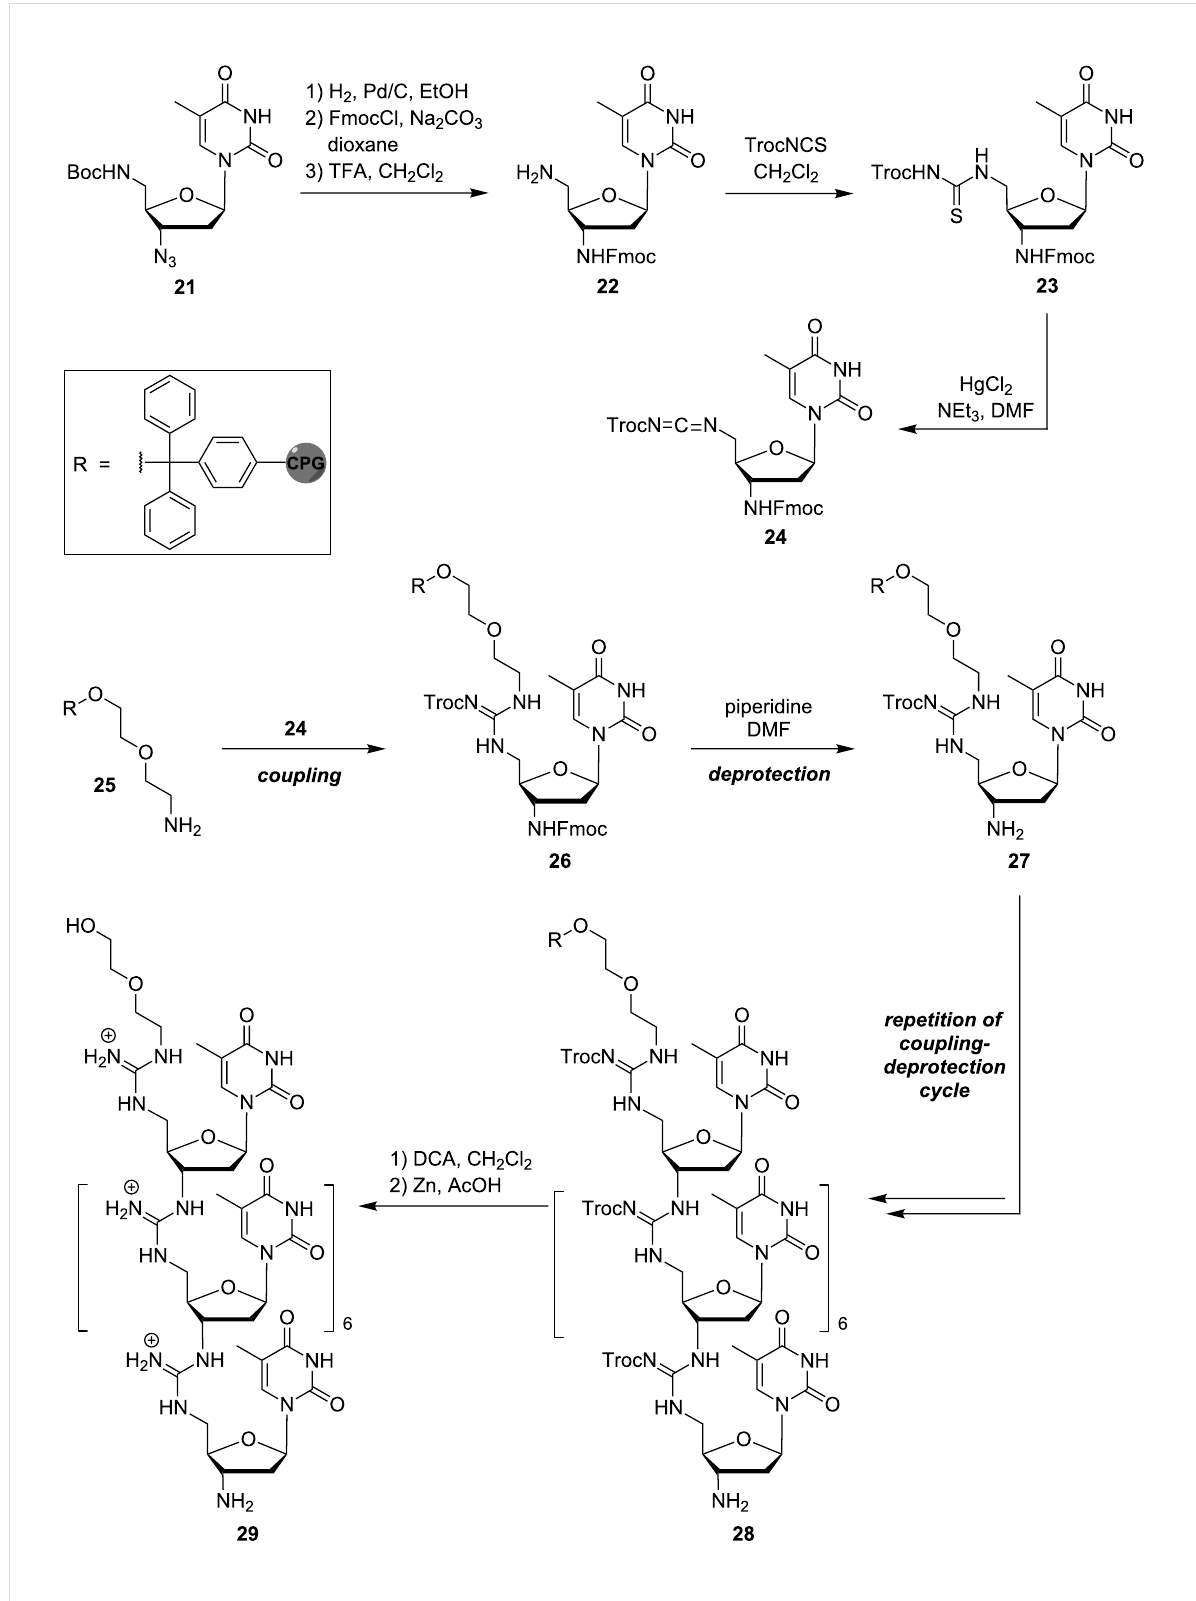
Scheme 2: Bruice's synthesis of guanidinium-linked DNG oligomer 29 in the 5' → 3' direction (Troc =